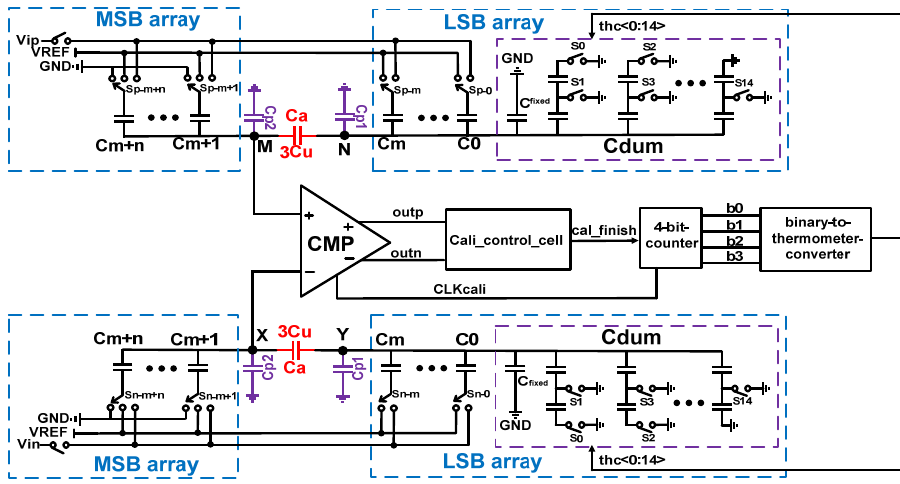
Figure 6. The calibration circuit of the non-linearity.